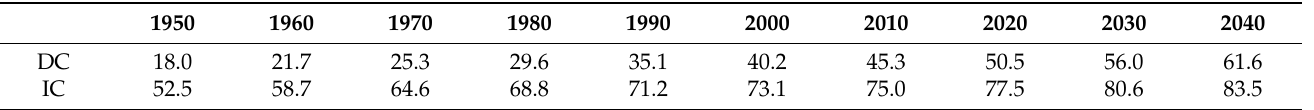
Table 1. Urbanization rate in percent of the total population in developing countries and industrial- ized countries